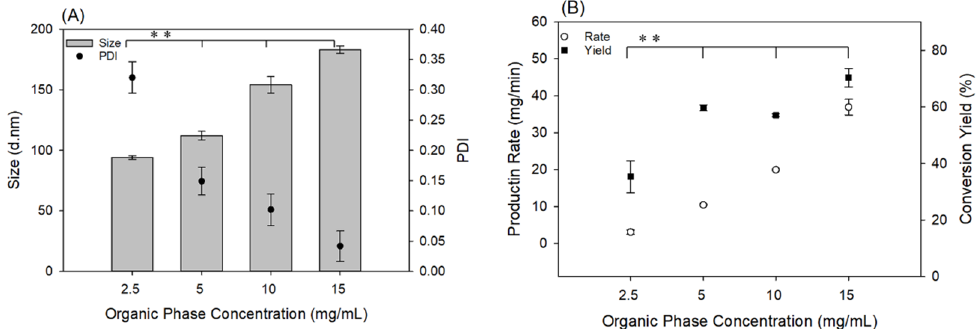
Figure 3. Effect of PLGA concentration on ( A ) NP size and PDI and ( B ) production rate and conversion yield. For this study, the flowrate of the PLGA solution (organic stream) was 3.5 mL/min, and the concentration and flowrate of the PVA solution (aqueous stream) was 10 mg/mL and 25 mL/min, respectively. ** Statistically significant difference in the size, PDI, production rate and conversion yield among all organic phase concentrations tested ( p < 0.05).